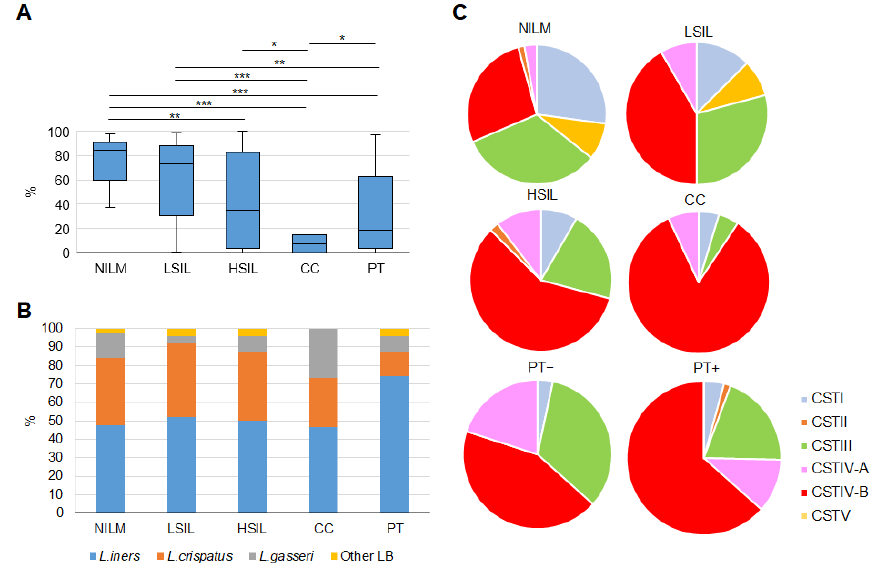
Figure 3. LB species analysis by 16S rRNA gene sequencing. ( A ) Enrichment with LBs (relative proportion of reads mapped to genomes of Lactobacillus spp.) at different diagnoses and post-treatment. multiple testing, and an adjusted p -value was calculated as a pairwise nonadjusted p -value multiplied by the total number of comparisons. The figure presents the median value, upper and lower quartiles, and a nonoutlier range; outliers are not shown. *** p ≤ 0.001, ** 0.001 < p < 0.01, * p < 0.05. ( B )